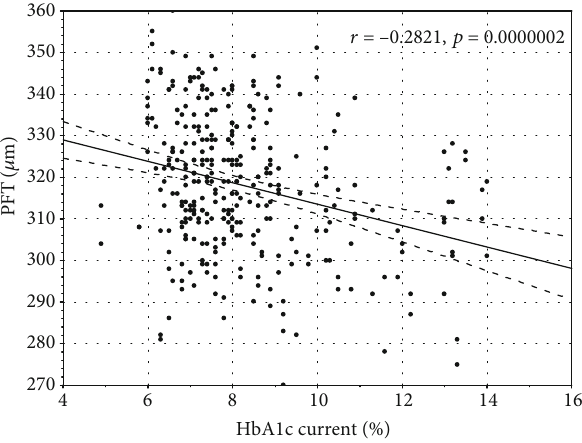
Figure 2: The correlation between current glycated hemoglobin A1c and parafoveal thickness.